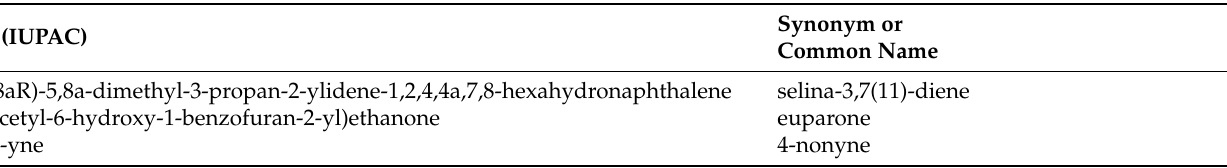
Table 3. LA1-specific VOCs with potential to be investigated as biocontrol